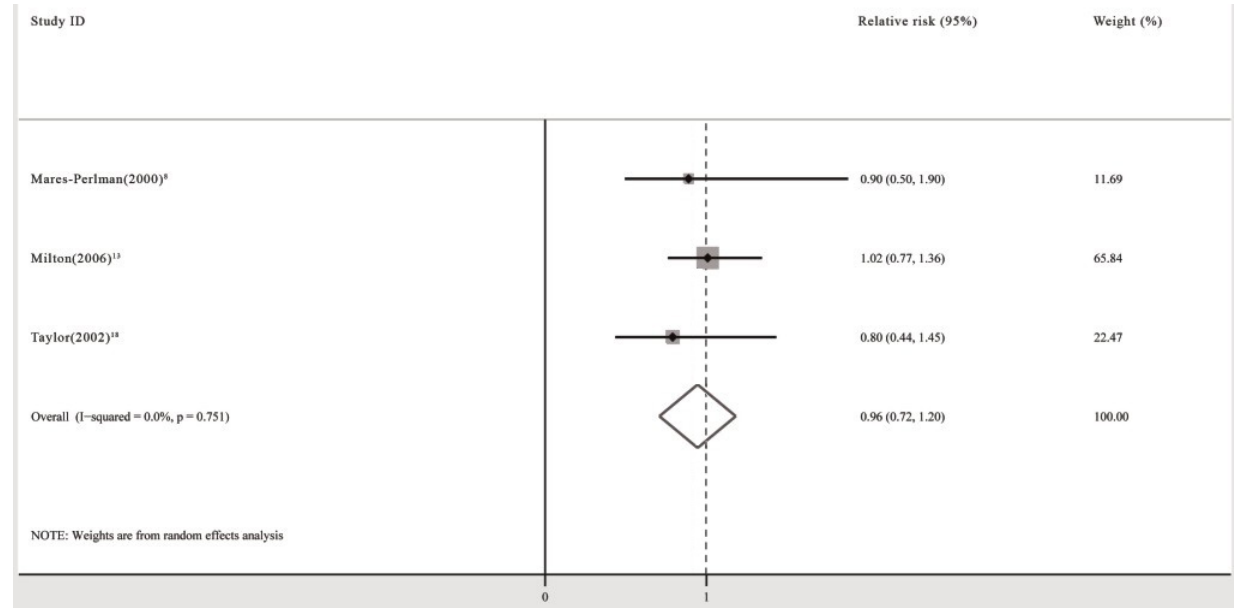
Figure 4. Pooled relative risk (95% CI) of posterior subcapsular cataracts comparing the longest duration of multivitamin/mineral supplementation with no